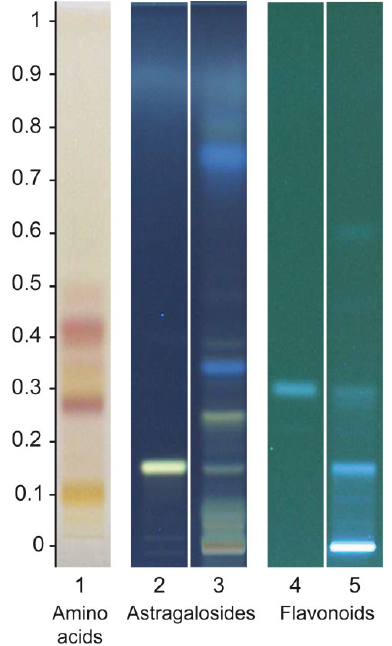
Figure 1. High-performance thin-layer chromatography (HPTLC) plate for amino acids, astragalosides and flavonoids. Track 1: A. mongholicus Bunge HRE (0.2 µ L), Track 2: astragaloside IV (2 µ L), Track 3: A. mongholicus Bunge HRE (1 µ L), Track 4: formononetin (4 µ L) and Track 5: A. mongholicus Bunge HRE (3.4 μ L).